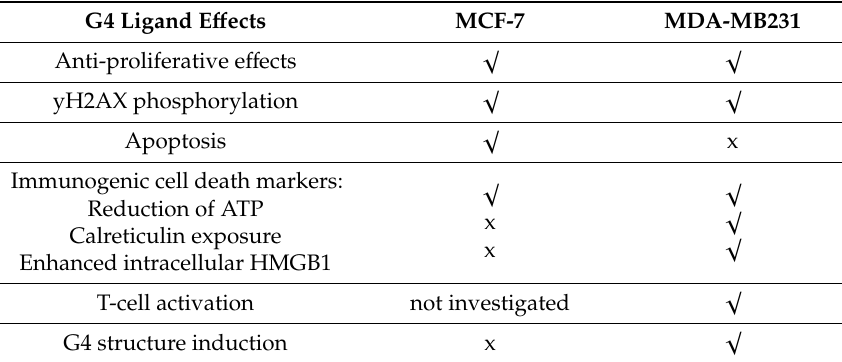
Table 1. C066-3108 and BRACO-19 activity in breast cancer cell lines.